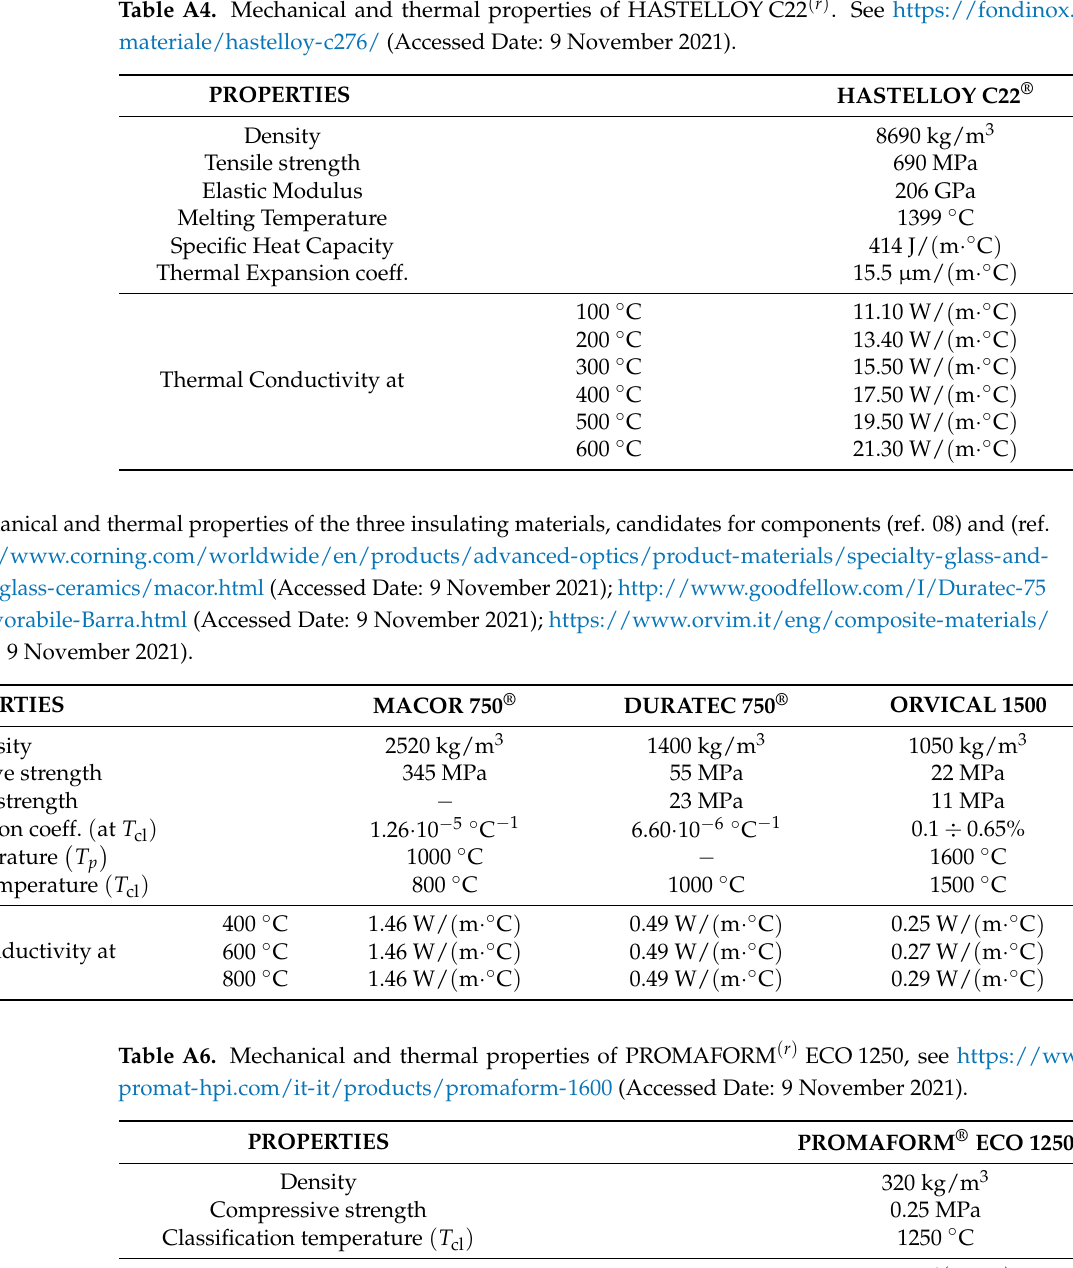
Table A4. Mechanical and thermal properties of HASTELLOY C22 ( r ) . See https://fondinox.it/